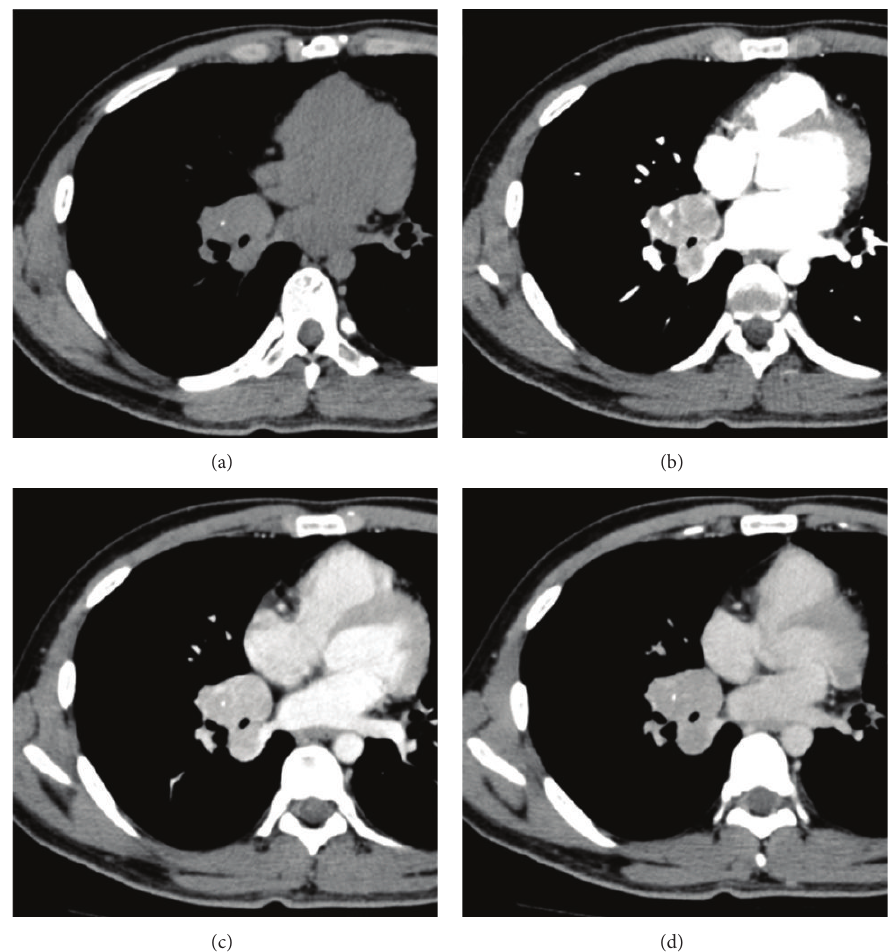
Figure 2: Dynamic CT scans of the chest, in plane (a), arterial (b), portal in-flow (c), and equilibrium (d), show a well-defined, lobulated, soft-tissue mass with small calcifications in the right lower lobe. The periphery of the mass was strongly enhanced in the arterial phase, and the parenchyma of the mass was heterogeneously enhanced in the portal in-flow to equilibrium